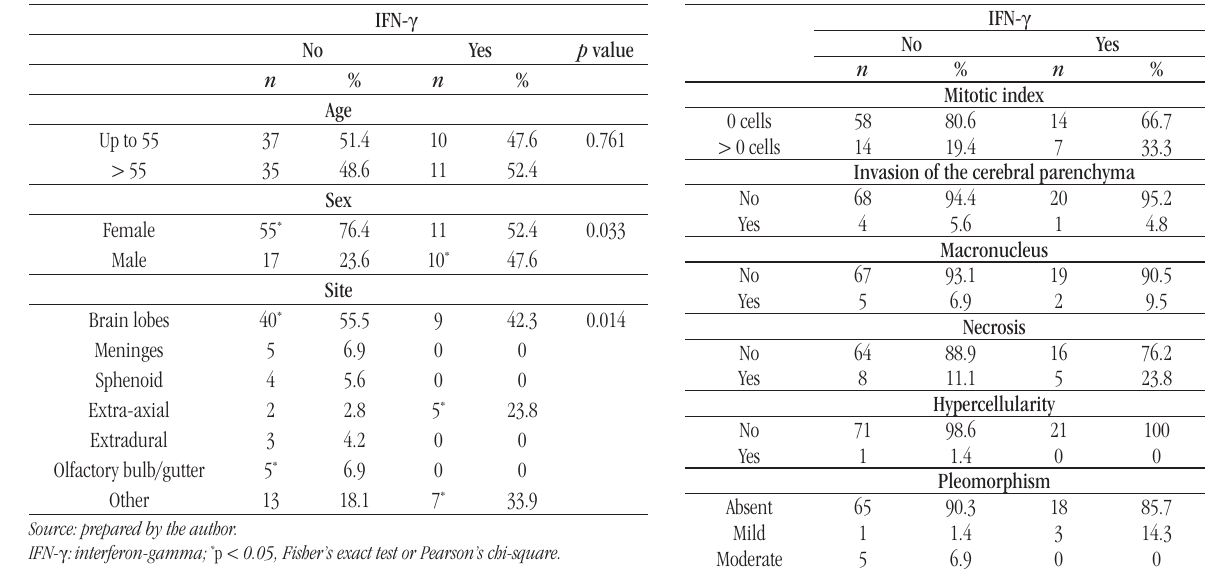
table 2 – Analysis of IFN- γ immunoexpression and its relationship with morphological variables in patients with meningioma